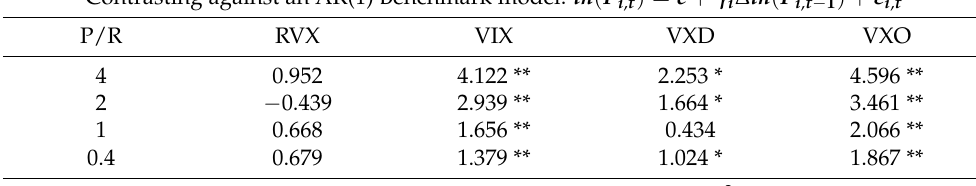
Table 4. Forecasting stock market implied volatility with financial reports tone disagreement: Out-of- sample analysis with the ENCNEW test.